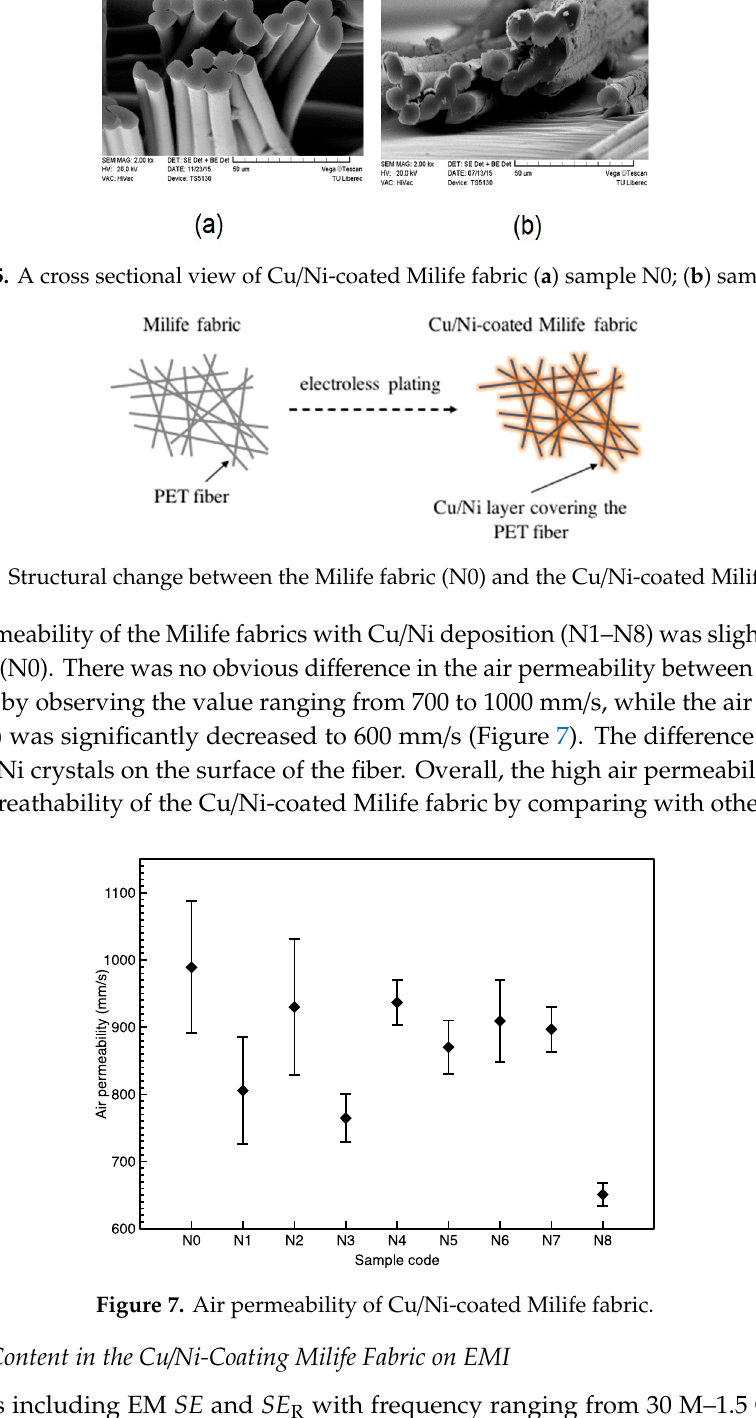
Figure 7. Air permeability of Cu/Ni-coated Milife fabric.